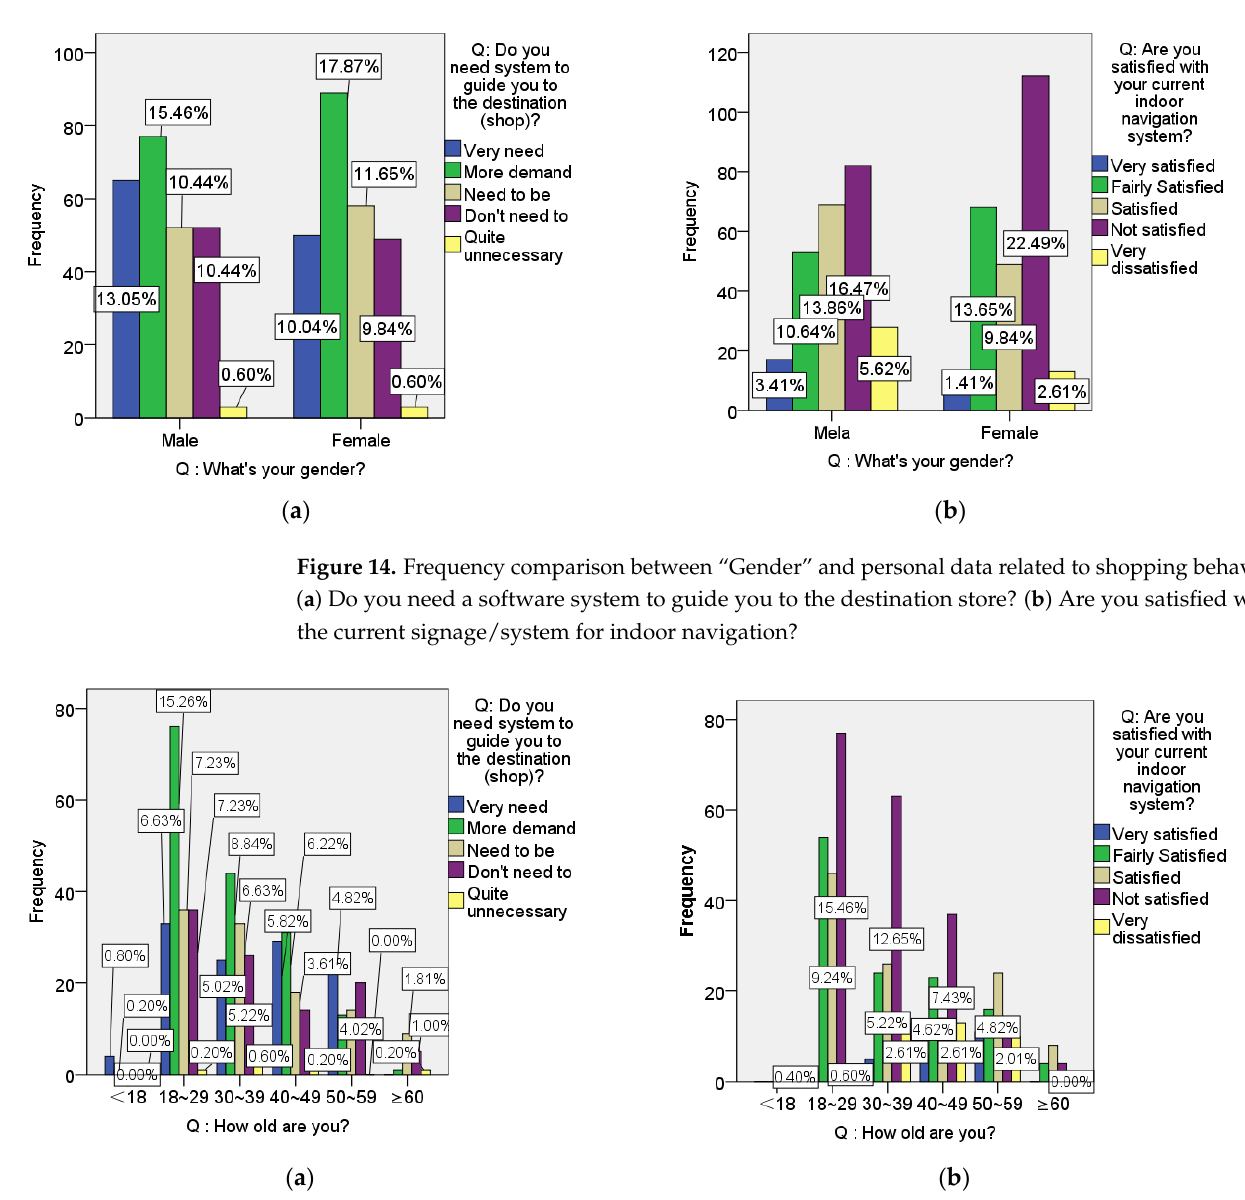
( b ) Figure 16. Frequency comparison of “ Occupation ” and personal data related to shopping behavior. ( a ) Do you need a software system to guide you to the destination store? ( b ) Are you satisfied with the current signage/system for indoor navigation? Students and office workers are selected as the main users. Young people, limited by their academic and economic abilities, tend to choose uncertain shopping malls, and they